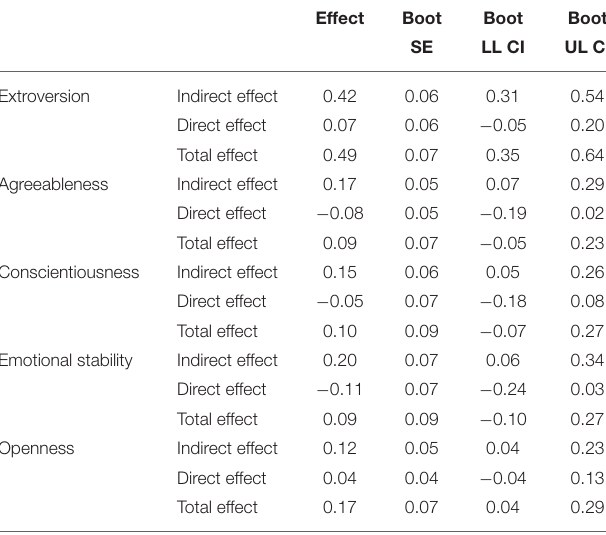
TABLE 2 | Direct effect, indirect effect, and total effect among the